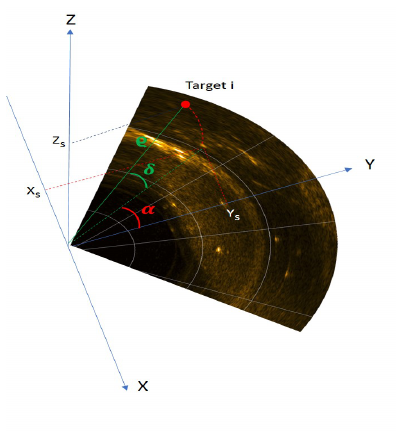
Figure 3. Forward Looking Sonar: beam forming and 2D image projection ( ∆ α and ∆ δ are receptive azimuth and elevation resolution and α i is the azimuth angle of beam i